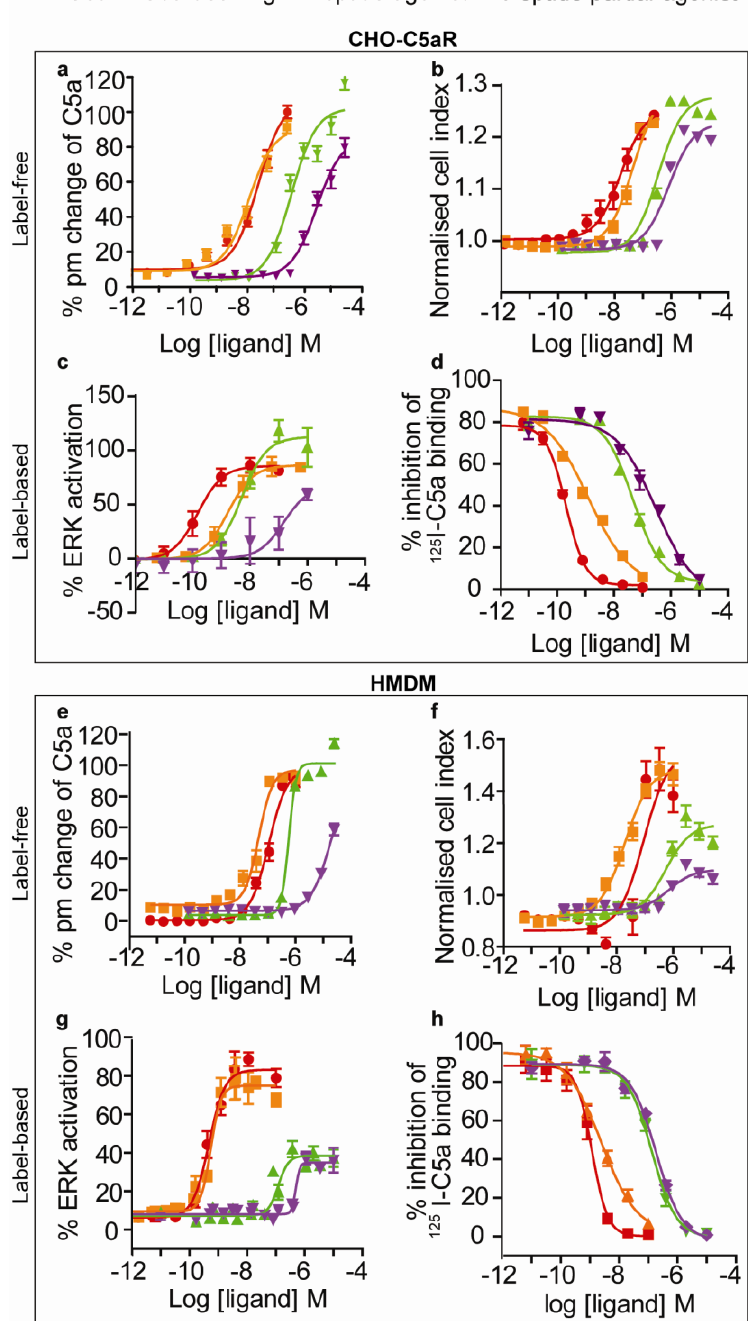
Figure 3. Label-free dose response curves on CHO-C5aR cells and HMDM. ( a ) Label-free response of all ligands on the EPIC ® optical system on CHO-C5aR cells ( b ) Label free response of all ligands on the xCELLigence impedance system on CHO-C5aR cells ( c ) Ligand response on Alphascreen secondary messenger ERK assay on CHO-C5aR cells and ( d ) I 125 binding assay of all ligands on CHO-C5aR membranes ( e ) Label-free response of all ligands on the EPIC ® optical system on HMDM ( f ) Label-free response of all ligands on the xCELLigence impedance system on HMDM ( g ) Ligand response on Alphascreen secondary messenger ERK assay on HMDM and ( h ) I 125 binding assay of all ligands on HMDM. Error bars represent standard error of the mean (n = 3 −